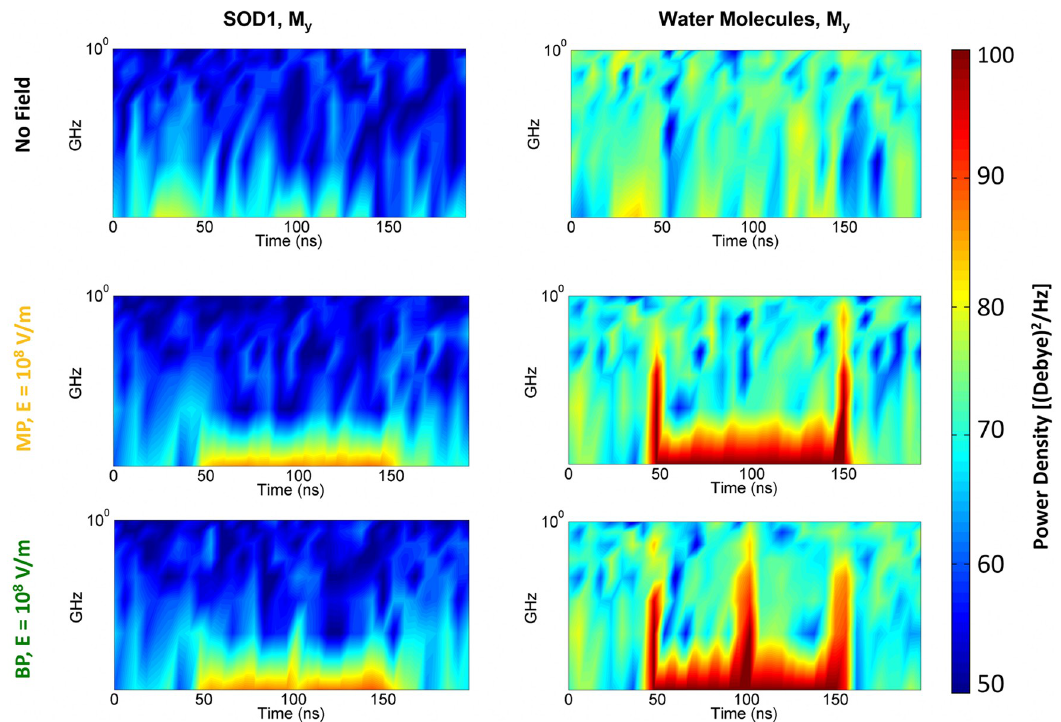
Fig 6. Frequency spectral content of the SOD1 and water dipole moment. Spectrogram representation of the dipole moment (y- component) of both Cu,ZnSOD1 protein and solvating water medium, reported in absence of any exogenous field (black label, first raw) and in presence of a 100 ns, 10 8 V/m MP (yellow label, second raw) and BP (green label, third raw).